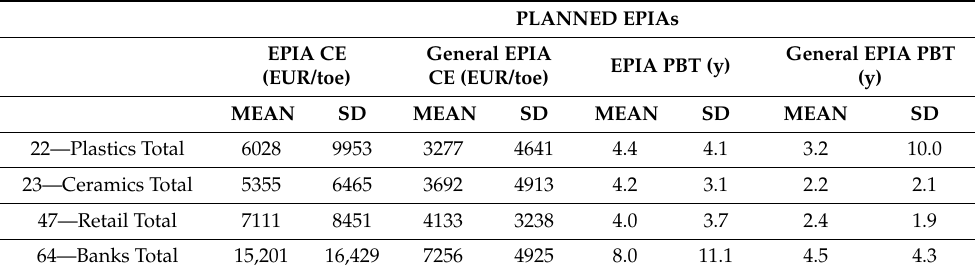
Table A4. Analysis of mean and standard deviation of CE and PBT for planned